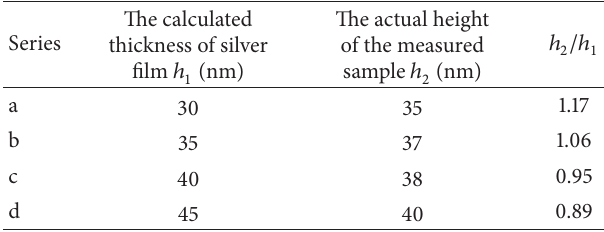
Table 1: The actual height ℎ 2 of the measured sample and the calculated thickness ℎ 1 of silver film.